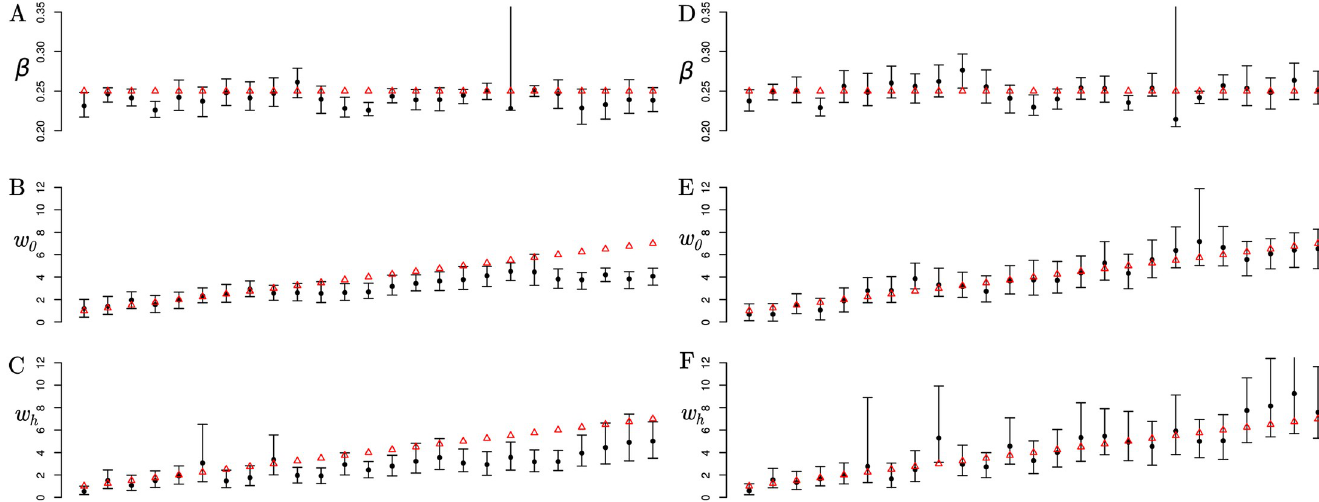
Fig 5. Parameter estimates and credible intervals for 25 simulations with variable transmission risk ratos. The red points show true parameter value. The parameter β is the per-capita transmission rate, and w 0 and w are respectively the transmission risk ratios in the first stage of infection and the high risk group (cf. Eq h 12). A-C: Results generated using the QL model. D-F: Results generated using the PL2 model. There is one outlier simulation where the transmission rate parameter could not be estimated precisely and upper bound of the CI was > 70% using both